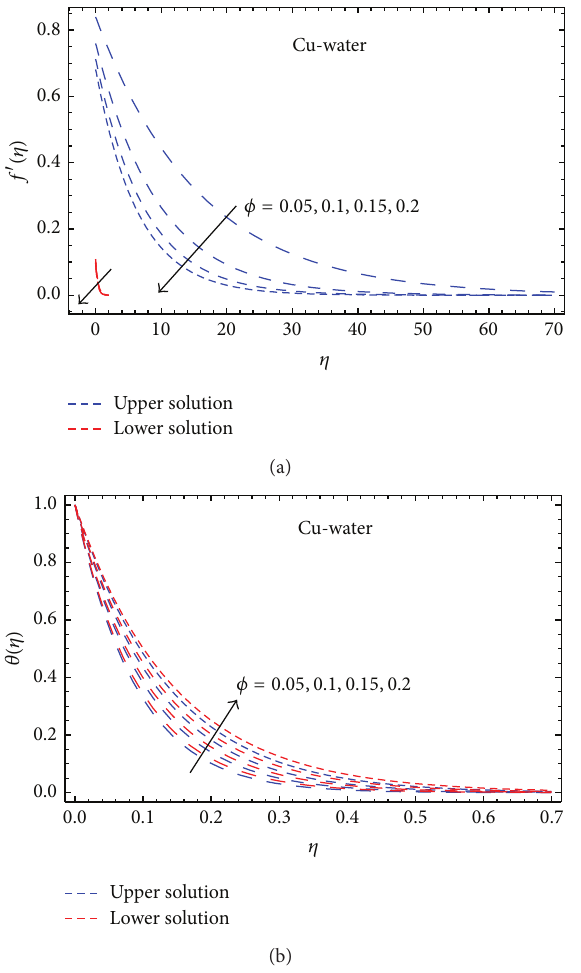
Figure 11: (a) Dual velocity for several values of 𝜙 at 𝑠 = 2 , 𝜆 = 3 , and 𝑀 = 1 . (b) Dual temperature for several values of 𝜙 at 𝑠 = 2 , 𝜆 = 3 , and 𝑀 = 1 .